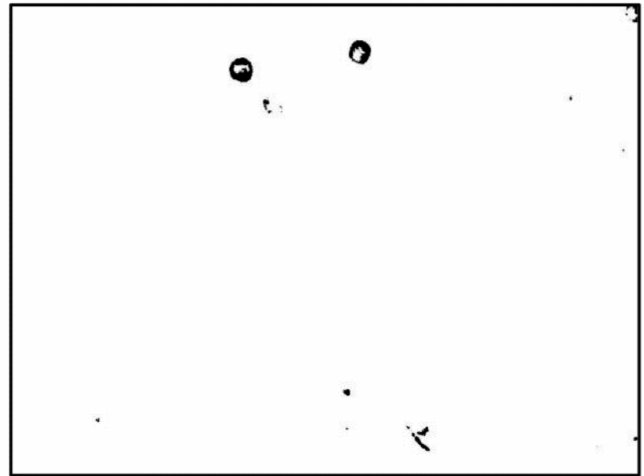
Figure 7. Image binarized using the OTSU method.